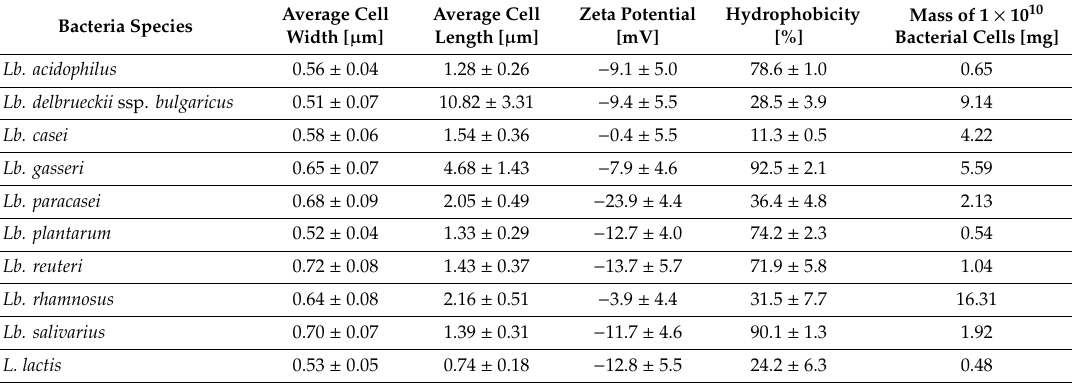
Table 2. Selected physical characteristics of the bacterial species used in this study.